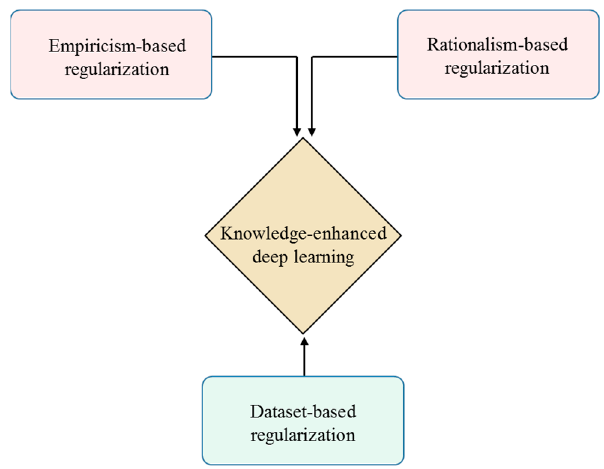
Figure 1. Schematic of knowledge-enhanced deep learning .